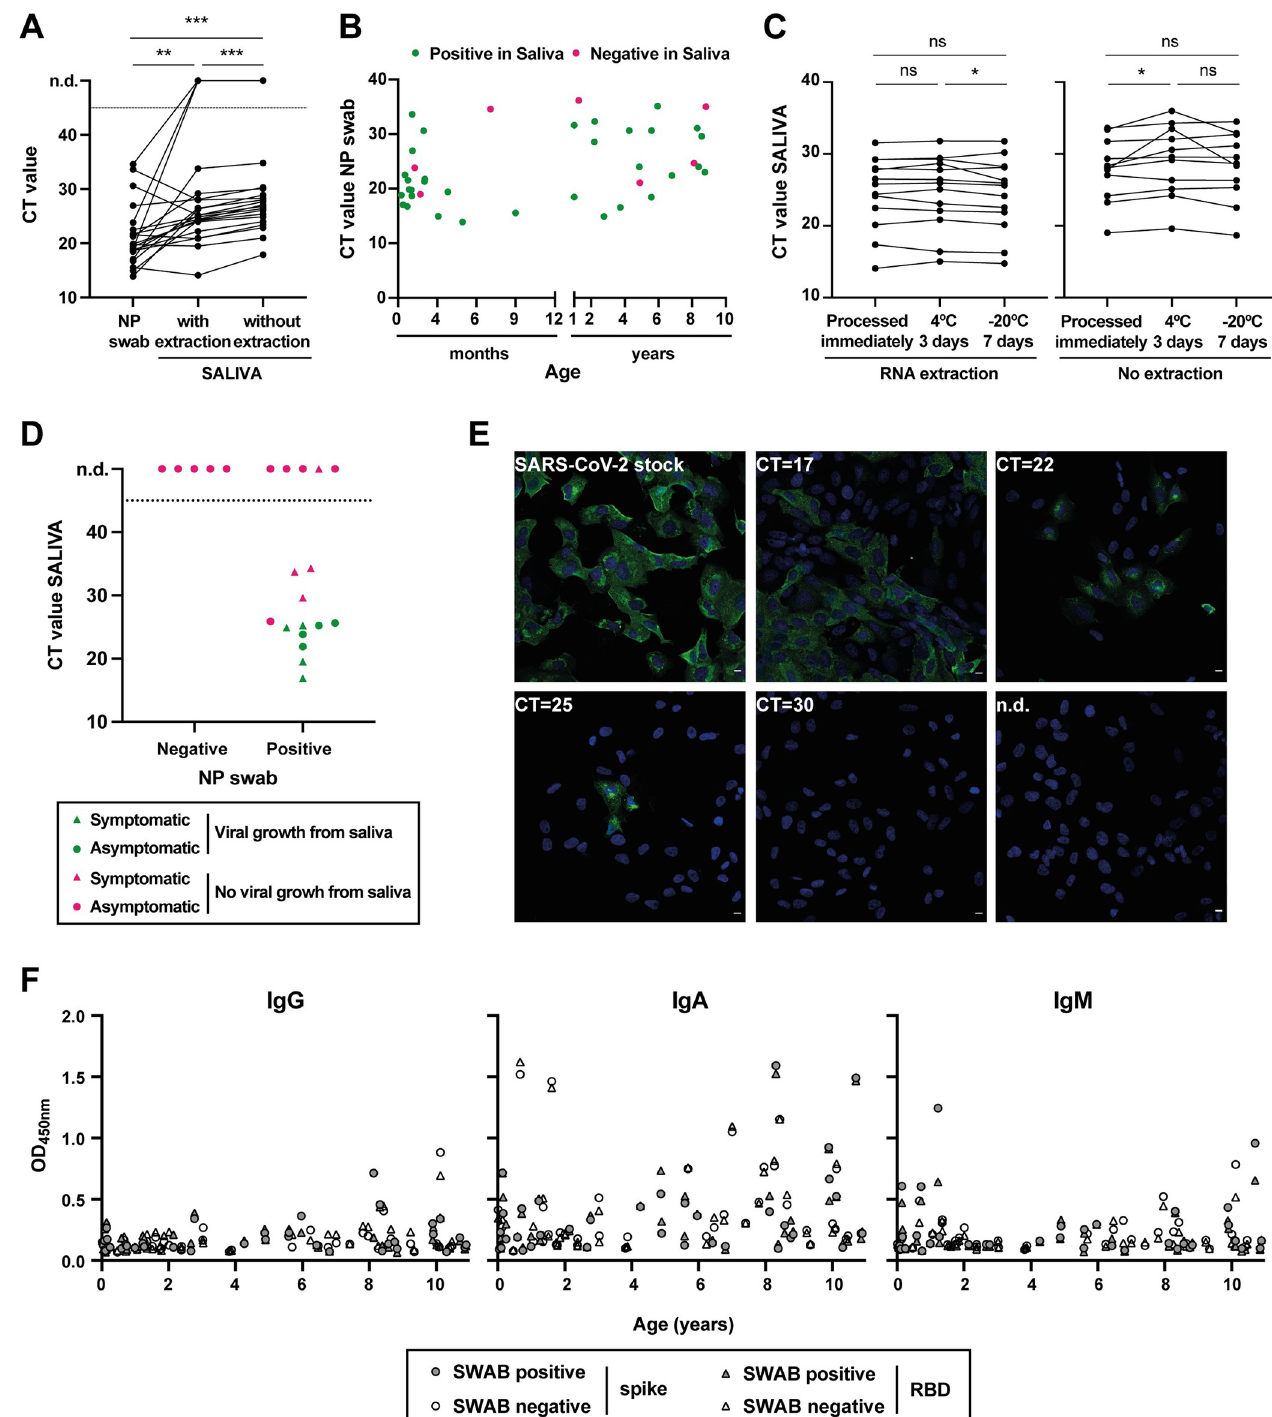
Fig 2. Detection of SARS-CoV-2 infection in NP swab and saliva samples from children. (A) Comparison of CT values from paired saliva (with and without RNA extraction) and NP swab specimens from children aged 10 years and under, positive for SARS-CoV-2 infection (N = 40). Each line corresponds to a paired specimen. n.d., not detected; �� p < 0.01, ��� p < 0.001, by Wilcoxon matched-pairs signed-rank test. (B) Graphical representation of CT values in NP swabs from infected children vs. age. Positive in saliva, green dots; negative in saliva, magenta dots. (C) Saliva stability at 4˚C and -20˚C: comparison of CT values from paired saliva samples [with (N = 13) and without RNA extraction (N = 11)] processed immediately, after 3 days at 4˚C or 7 days at -20˚C. ns, not significant; � p < 0.05, by Wilcoxon matched-pairs signed-rank test. (D, E) Infectious SARS-CoV-2 growth from saliva samples. Vero E6 cells were inoculated